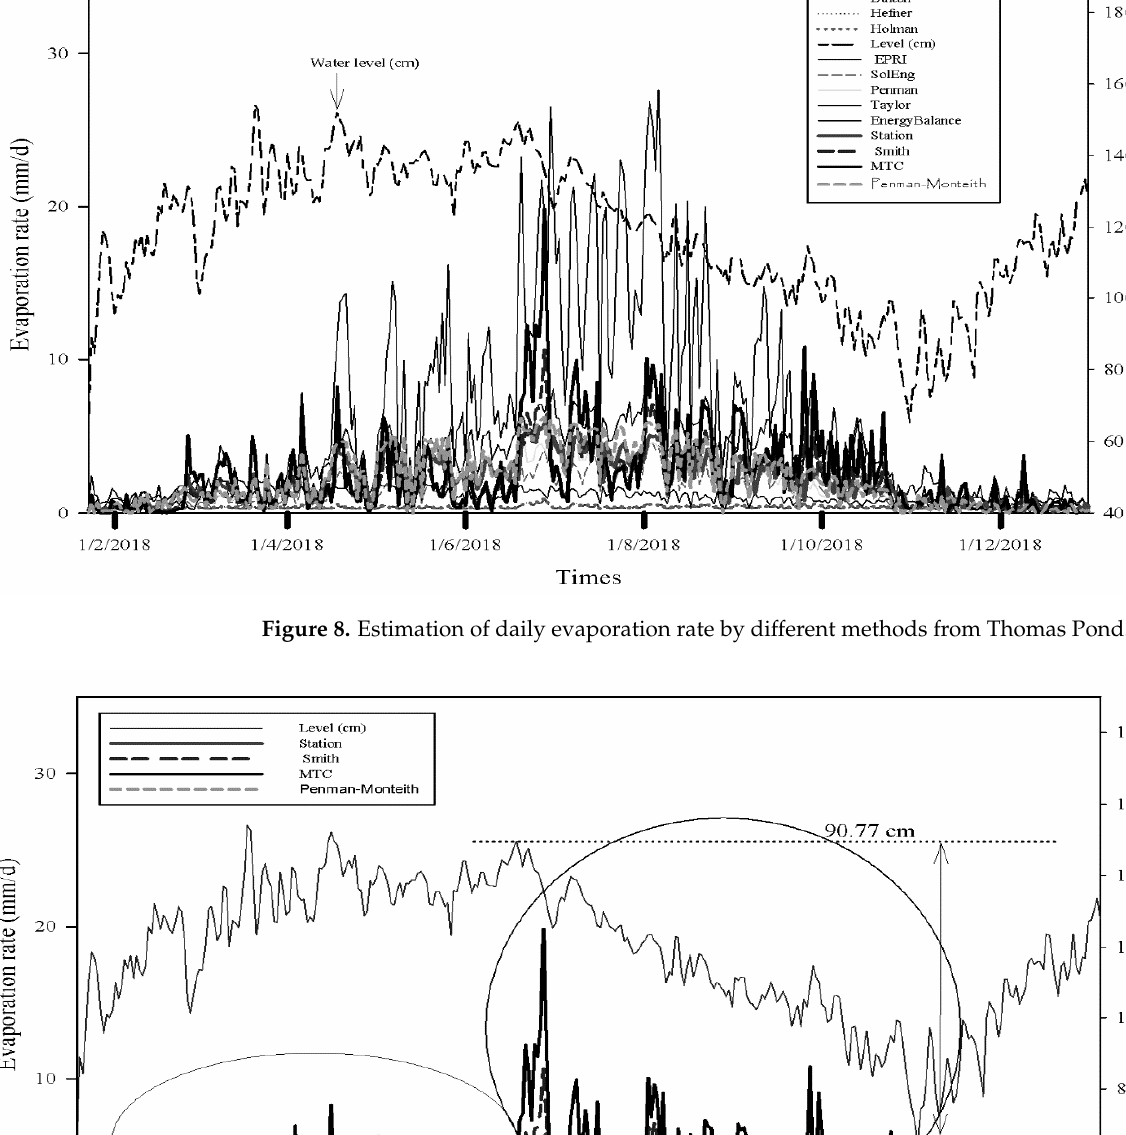
Table 3. Correlation matrix of evaporation rates estimated using the different methods for the year 2018 at Thomas Pond.